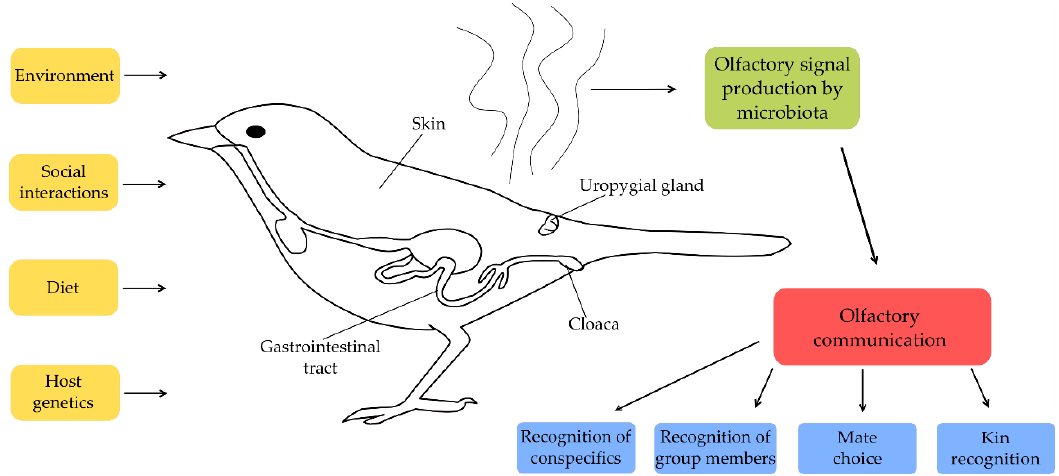
Figure 1. Possible factors involved in shaping microbiota-based communication.